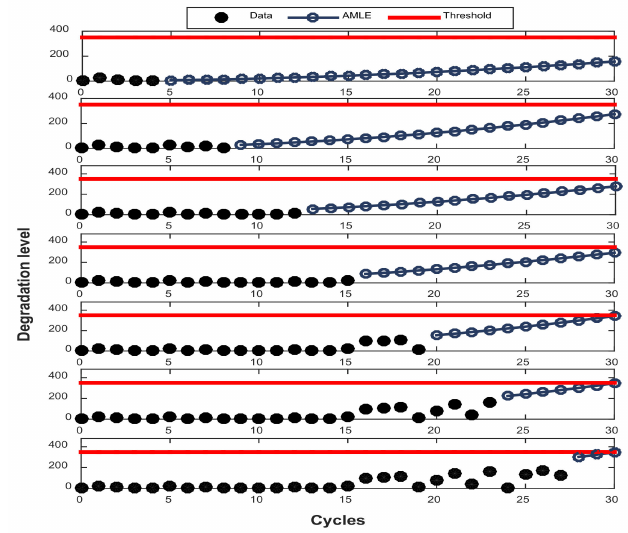
Figure 15. Degradation level with a different number of data points. Reproduced from [51], Wiley.